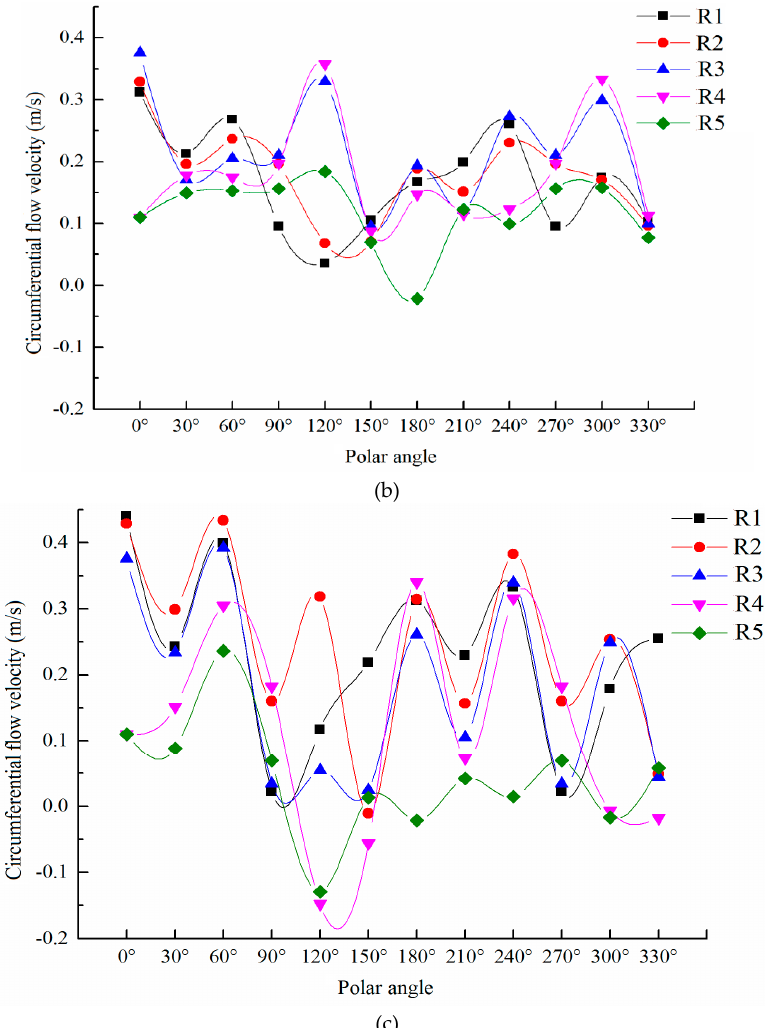
Figure 16. Circumferential velocity of the same measuring ring: ( a ) rear section; ( b ) middle section; and ( c ) front section.